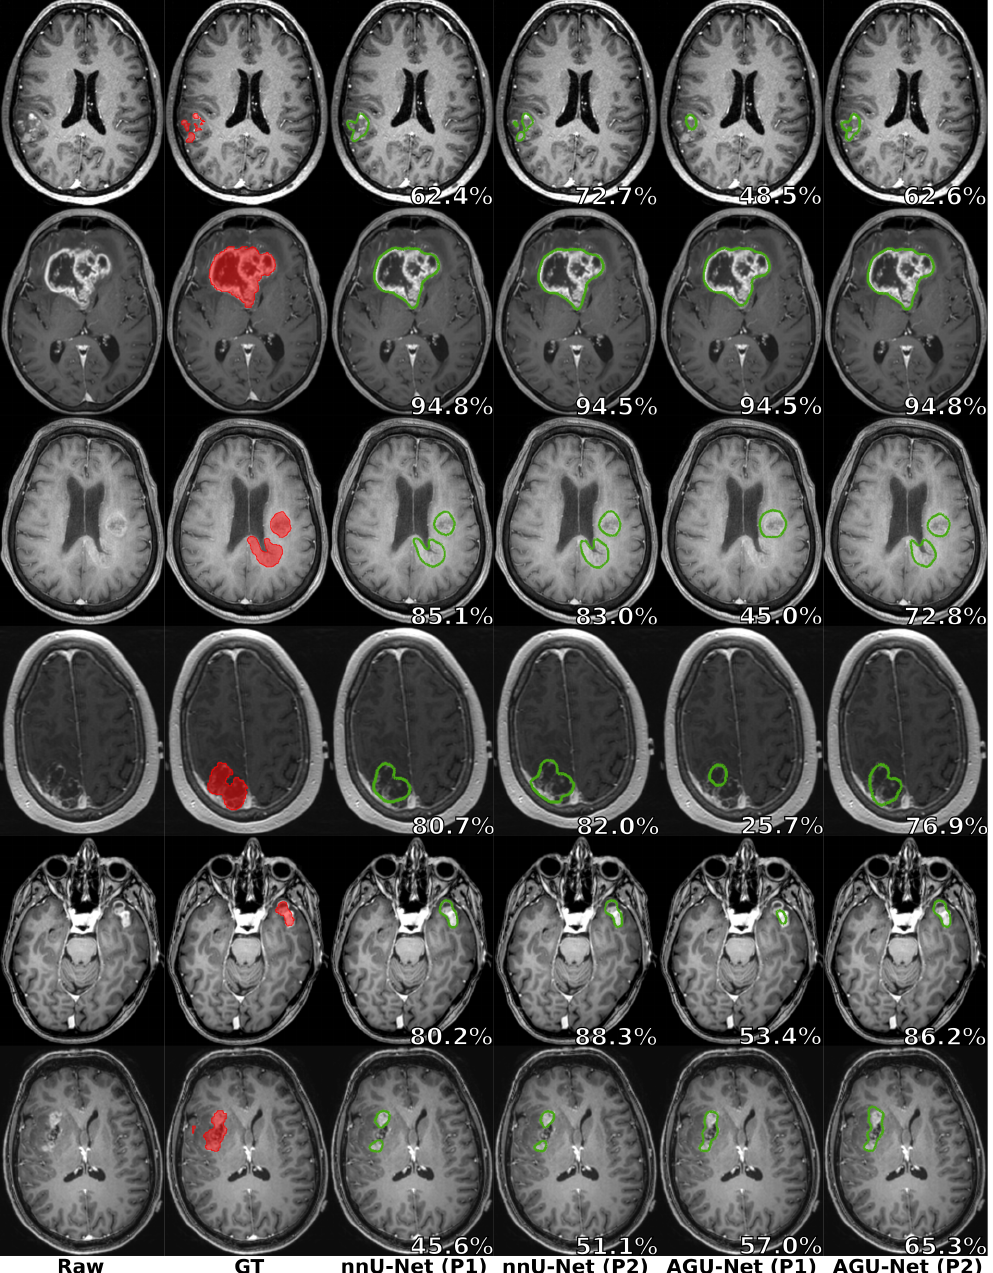
Figure 4. Segmentation comparison between the manual ground truth (overlaid in red) and the predictions (outlined in green) from the two architectures and with the two different preprocessing schemes. One patient is featured per row, and the overall raw Dice score is reported in white (best viewed digitally and in